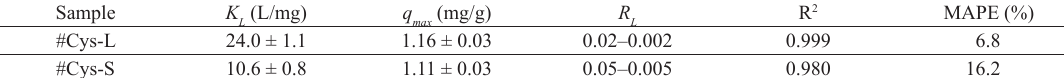
Table 3. The fitted parameters for Pb(II) adsorption using the linearized Langmuir model. Sample